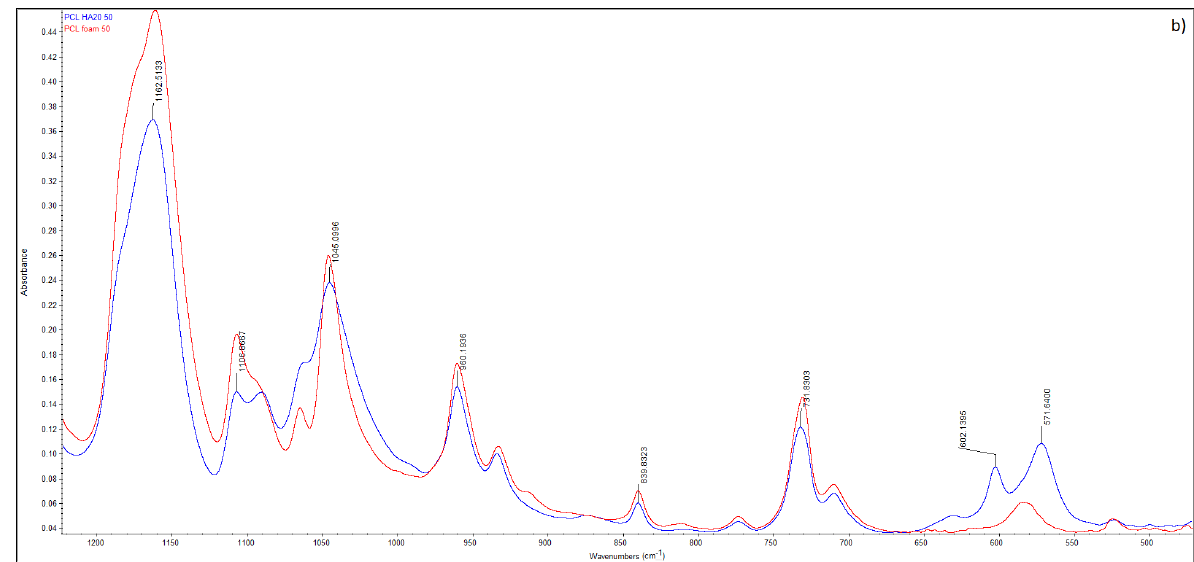
2 theta of 21.77° and 24.08°, corresponding to the (110) and (200) Bragg reflections. For